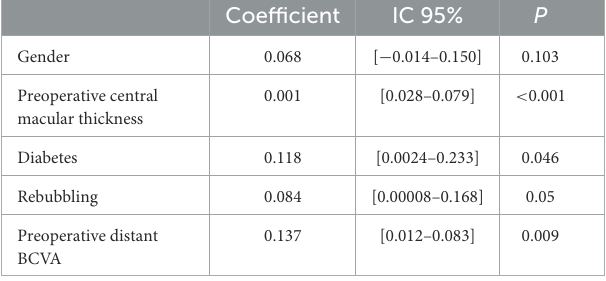
TABLE 3 Multiple linear regression model for distant BCVA at 1